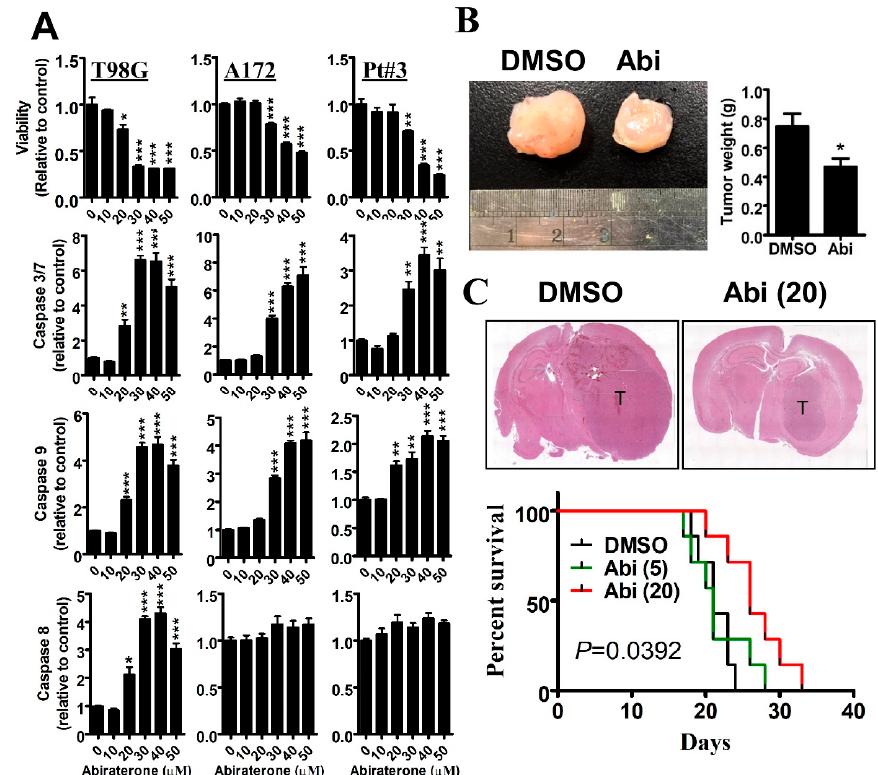
Figure 1. Effect of abiraterone (Abi) on glioblastomas in vitro and in vivo. ( A ) After treatment with different doses of Abi for 48 h, cells were subjected to MTT assay for evaluating viability. Cultured media were collected and analyzed for caspases 3/7, 8 and 9. Data were expressed as the relative value ± standard error of the mean (SEM) (* p < 0.05, ** p < 0.01 and *** p < 0.001 indicate the significant difference between the control group without treatment and other groups with Abi treatment) ( B ) Fourteen days after subcutaneous transplantation with PT#3 cells (1 × 10 6 ), mice were administrated intravenously with 20 mg/kg Abi for 3 weeks (3 times/week). Excised tumors were photographed and weighed. Data were expressed as mean ± SEM (*p < 0.05). ( C ) Ten days after intracranial transplantation with PT#3 cells (2 × 10 5 ), mice were administrated intravenously with 20 mg/kg Abi until death (3 times/week). After sacrificing, the brain was paraffin-embedded and subjected to slide preparation followed by hematoxylin and eosin (HE) staining. The date of death was recorded, and the survival rate was compared using the log-rank test.